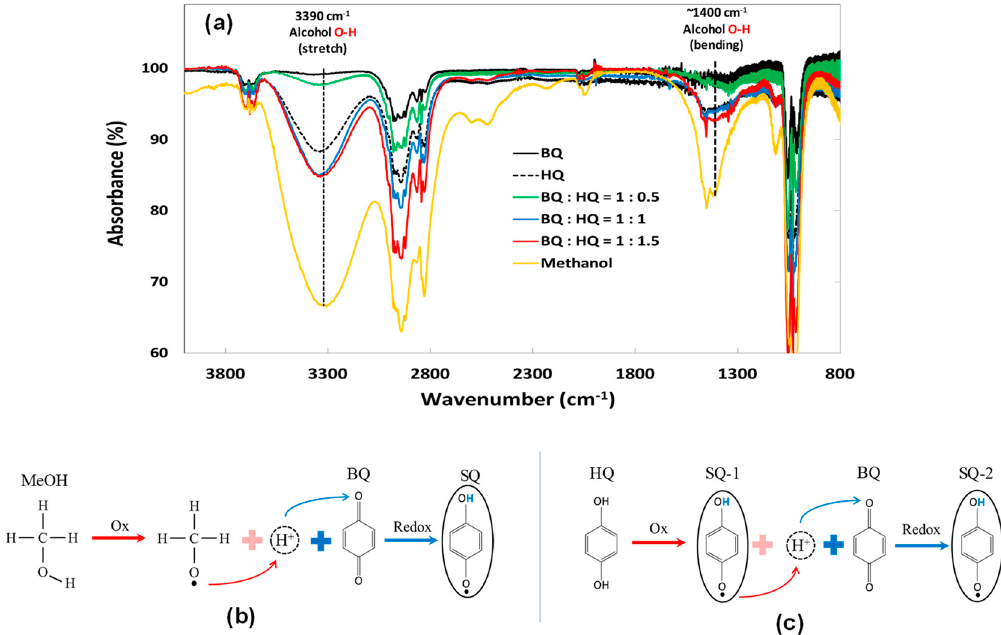
Figure 4. ( a ) Fourier transform infrared spectroscopy (FT-IR) results of BQ (black-solid line), HQ (black-dash line), and various HQ mixture ratios into fixed BQ in MeOH (green, blue, red-solid line) and pure MeOH (orange-solid line); ( b ) reducing reaction of BQ into one SQ in BQ/MeOH; and ( c ) effect of HQ to produce two SQs formation in QHY (BQ:HQ = 1:1)/MeOH.